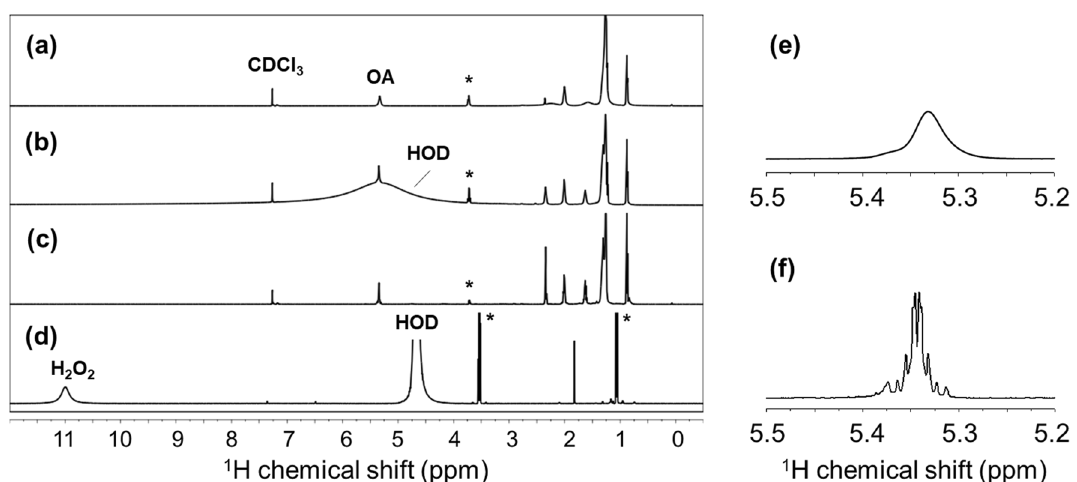
Figure 3. 1 H NMR spectra of InP/ZnS-OA: ( a ) as-prepared sample in CDCl 3 , ( b ) after treatment with 50 μL of H 2 O 2 , ( c ) CDCl 3 fraction, and ( d ) D 2 O fraction. The CDCl 3 and D 2 O fractions were obtained after the centrifugation of H 2 O 2 -treated samples. The 1 H signals at 5.35 ppm (vinyl protons of OA) for the as-prepared sample in CDCl 3 ( e ) and for the CDCl 3 fraction sample separated after H 2 O 2 treatment ( f ) are shown to stress that H 2 O 2 treatment and phase fractionation effectively reduced the signal width of ligand molecules. Asterisks (*) indicate the signals of residual ethanol from purification procedure of